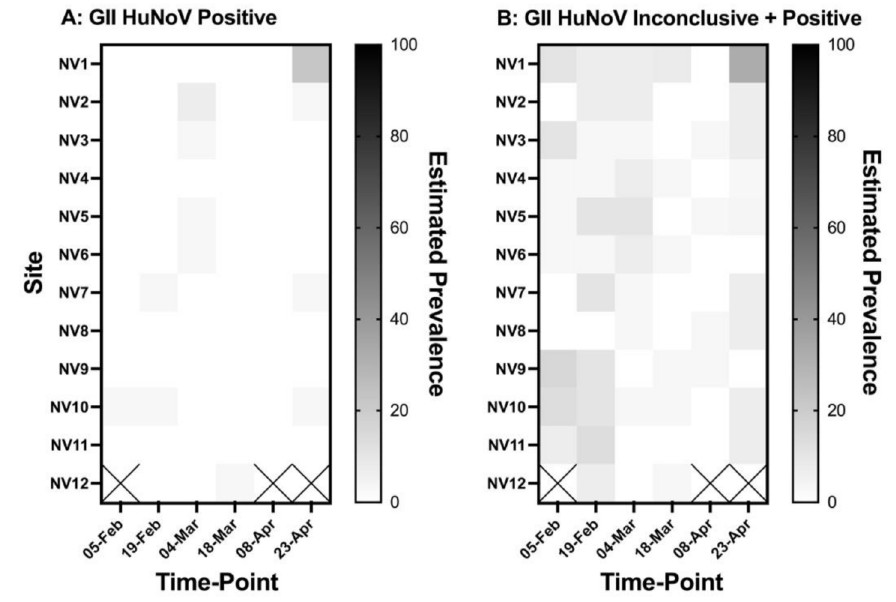
Figure 1. Change in the estimated prevalence for GII HuNoV between sample locations and time- points. Prevalence was calculated for both positive cases ( A ) and positive and inconclusive cases combined ( B ). The locations where sentinel oysters were deployed is presented in Figure 2.